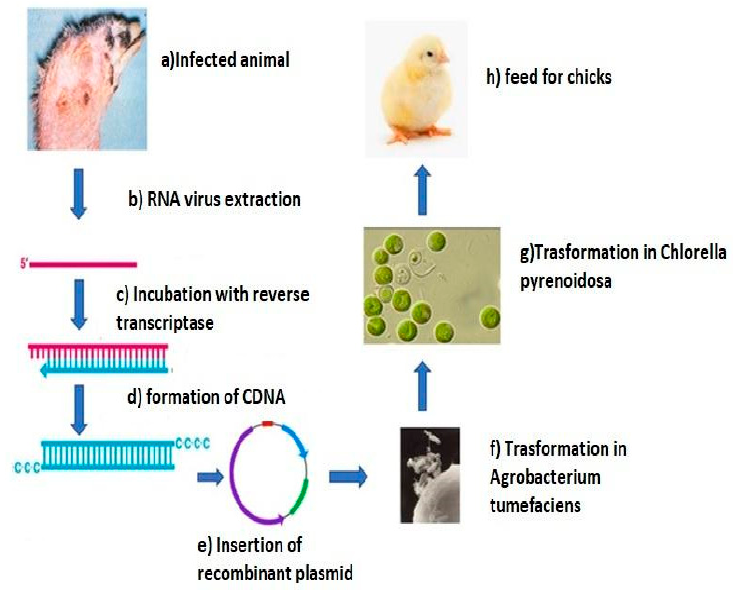
Figure 4. Experiment of Reddy et al. [132].